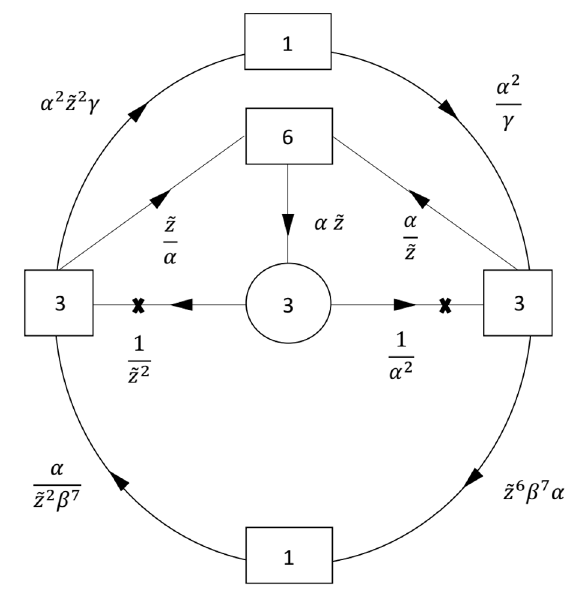
Figure 20 . The tube we get by gluing the tube in figure 19(a) with the one in figure 19(b). As usual, we have denoted the charges under the non-R symmetries using